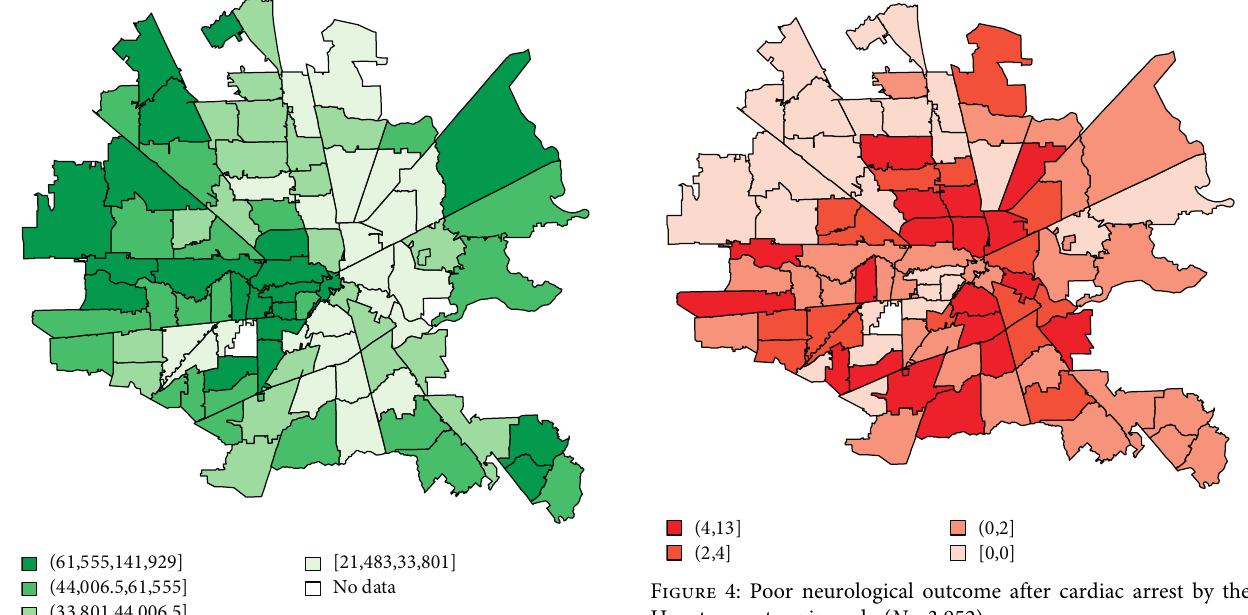
Figure 2: Median income by the Houston metro zip code ( N � 3,952).